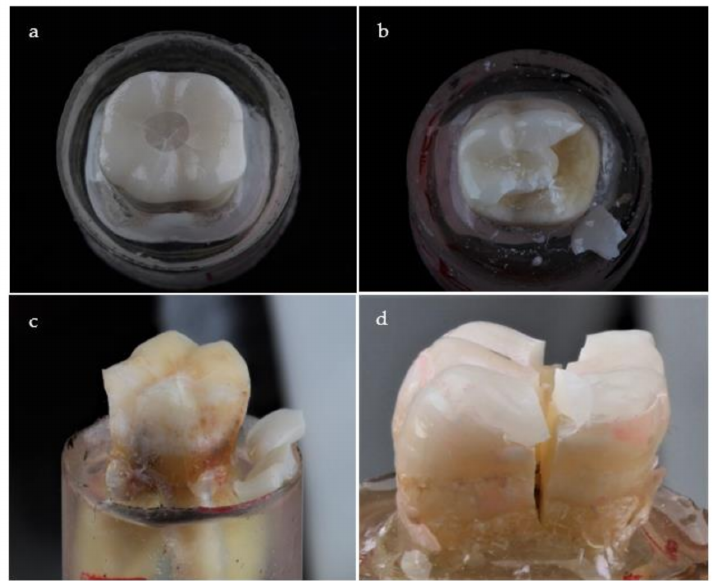
Figure 4. Representative fracture modes of failed specimens: ( a ) Class I: crack formation within restoration without chipping; ( b ) Class II: cohesive fracture within restoration without involving the tooth structure; ( c ) Class III: adhesive fracture between the restoration and tooth; and ( d ) Class IV: longitudinal fracture of the restoration and